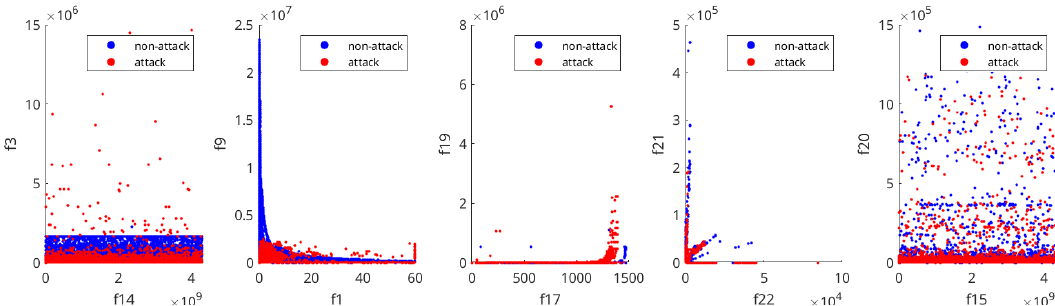
Figure 1. Scatter plots of randomly selected UNSW-NB15 numerical features. The ’attack’ class is superimposed to the ’non-attack’